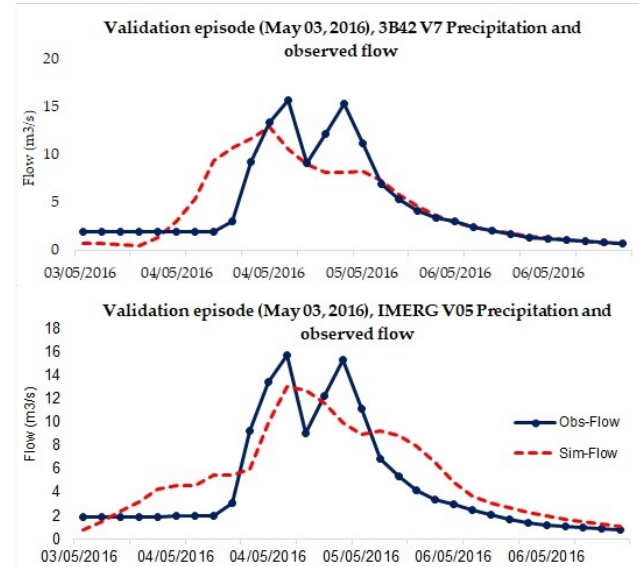
Figure 7. Validation of the episode of 3 May 2016, of 3B42V7 and IMERG V05 rainfall products and observed runoff data as input using the means calibration parameters of the gauge precipitation calibration.